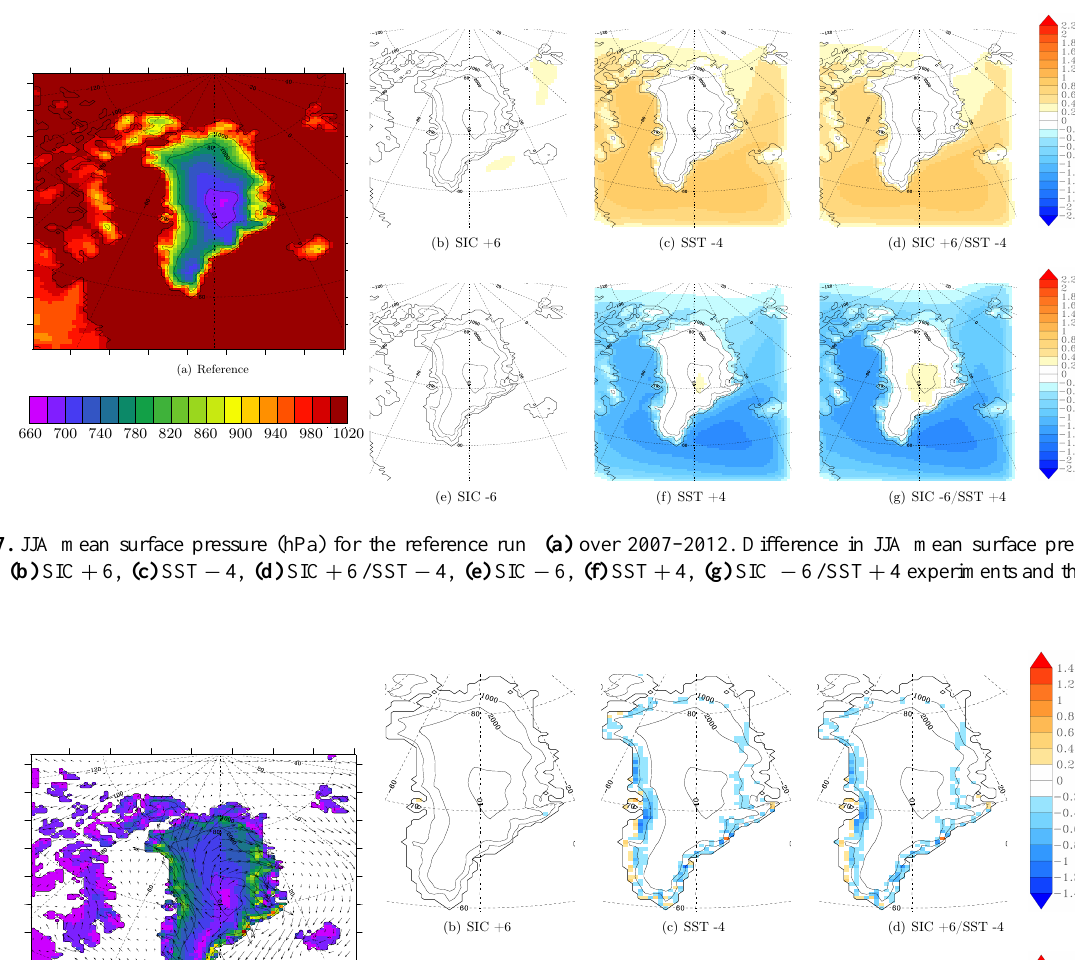
(i.e., sea ice-free Arctic Ocean in summer) and SST